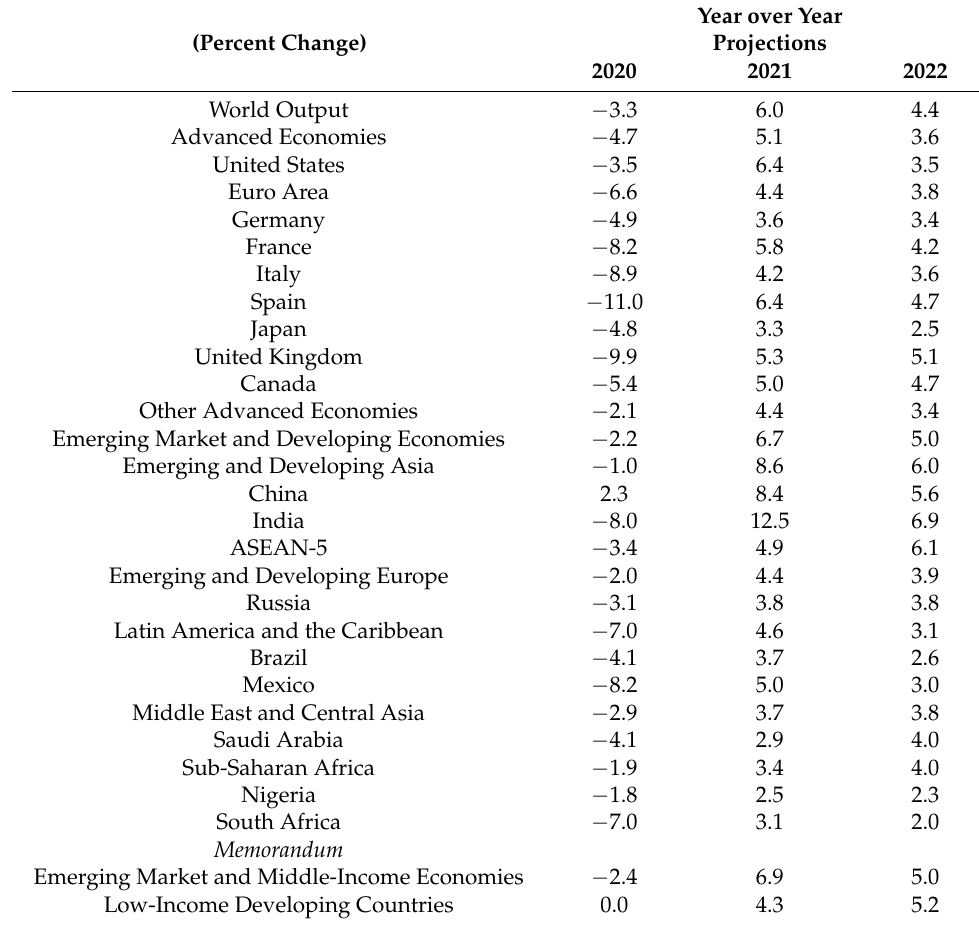
Table 1. Overview of the World Economic Outlook